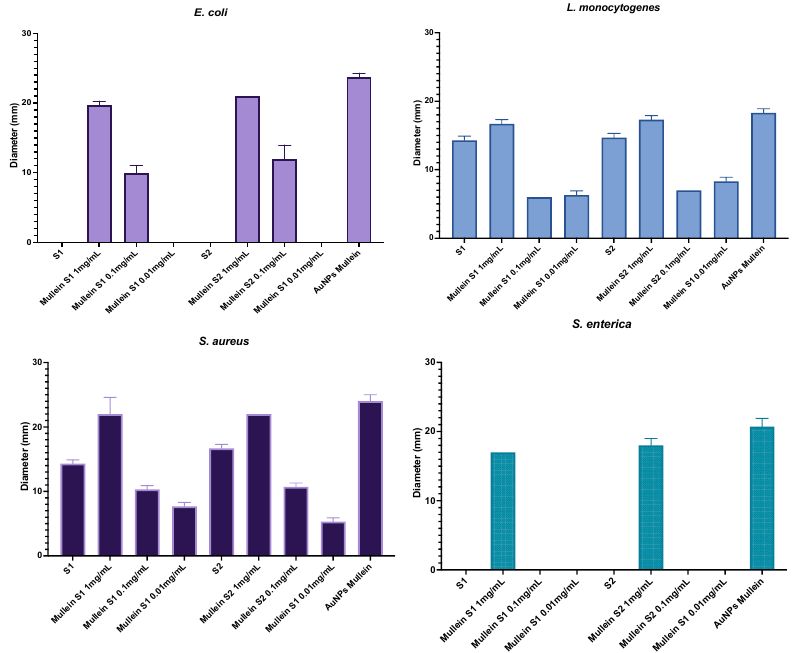
Figure 6. Antibacterial activity of silica-gold nanoparticles and AuNPs in different con- centrations.